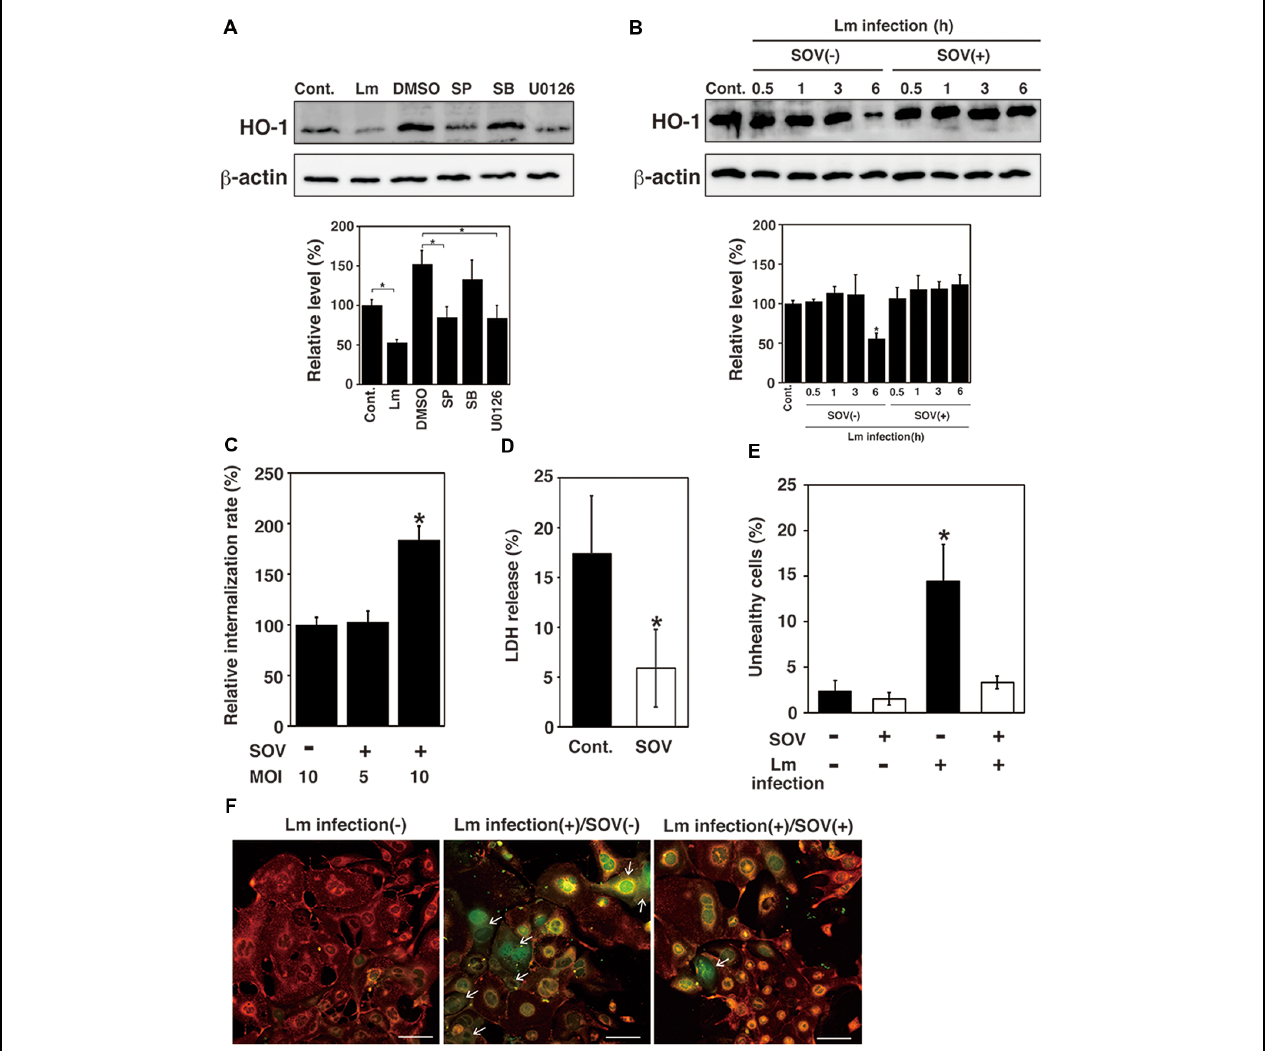
FIGURE 2 | Dephosphorylation of MAPK family proteins induces downregulation of HO-1 and TG cell death. (A) Effect of MAPK inhibitor treatment on HO-1 expression. TG cells were infected with L. monocytogenes (Lm) for 6 h, treated with or without (Cont.) SP600125 (SP; JNK inhibitor, 25 μ M), SB203580 (SB; p38 inhibitor, 25 μ M), U0126 (ERK1/2 inhibitor, 25 μ M), or DMSO 1 h before infection, respectively. Expression of HO-1 was detected by immunoblotting. β -actin was used as an immunoblotting control. (B) Effect of SOV treatment on HO-1 expression. TG cells were infected with or without (Cont.) L. monocytogenes in the presence (SOV + ) or absence (SOV–) of SOV (100 μ M) for the indicated number of hours. HO-1 expression was detected by immunoblotting. β -actin was used as an immunoblotting control. (A,B) The intensity levels of HO-1 expression were measured using Multi gauge software and normalized by the value of β -actin. Relative values to the intensity without infection (Cont.) were shown. All values represent the means and SD of three assays. ∗ P < 0.05 compared with Cont. by post hoc Tukey–Kramer test. (C) Relative bacterial internalization rate. TG cells were infected with L. monocytogenes in the presence (SOV + ) or absence (SOV–) of SOV (100 μ M), for 30 min at an multiplicity of infection (MOI) of 10 or 5. All values represent the means and SD of triplicate samples from three assays. ∗ P < 0.05 compared with bacterial internalization in TG cells lacking SOV by post hoc Tukey–Kramer test. (D) Detection of cytotoxicity by LDH release. TG cells were infected with L. monocytogenes in the presence (SOV) or absence (Cont.) of SOV (100 μ M) at an MOI of 10 (SOV–) or 5 (SOV + ). The amount of LDH released was measured after 6 h of infection. All values represent the means and SD of triplicate samples from three assays. ∗ P < 0.05 compared with Cont. by Student’s t -test. (E) Detection of cell death. TG cells were infected with L. monocytogenes in the presence (SOV + ) or absence (SOV–) of SOV (100 μ M) for 30 min at an MOI of 10 (SOV–) or 5 (SOV + ). Cell death was determined using the JC-1 Mitochondrial Membrane Potential Assay Kit after 6 h of infection. The total number of live or dead cells was determined by examination of 100 TG cells per coverslip. All values represent the means and SD of three assays. ∗ P < 0.05 compared with control by post hoc Tukey–Kramer test. (F) Fluorescence microscopic images of cell death. Red or green fluorescence indicates healthy and unhealthy cells, respectively. Arrows indicate dead cells. Bar represents 100 μ